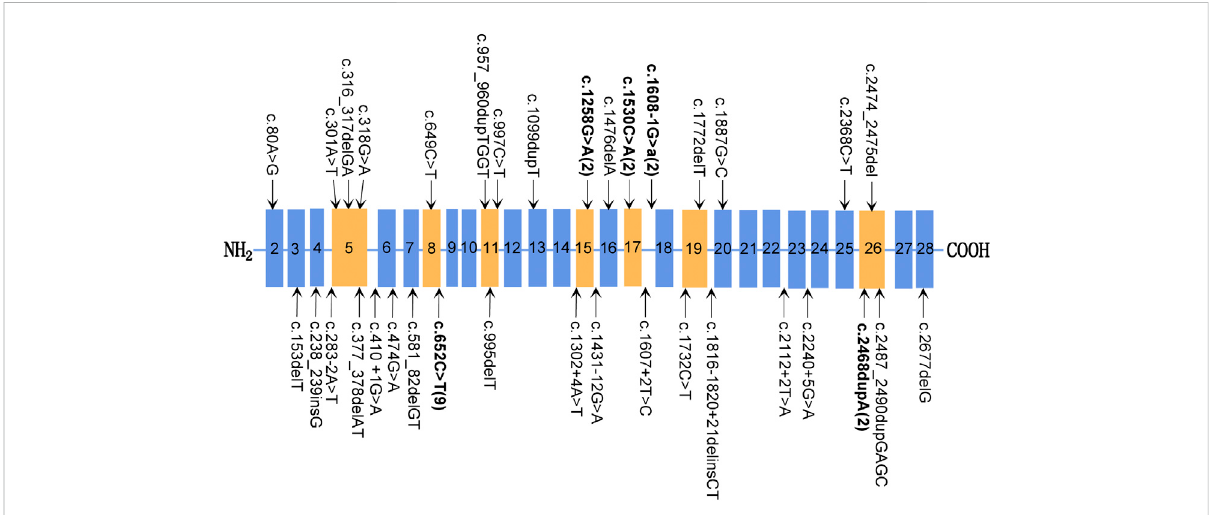
FIGURE 4 Mutations of the SPINK5 gene. Typical exon domains are represented in orange, and other exon domains are depicted in blue. Mutations occurring more than once are shown in bold, and the number of unrelated families carrying this mutation is shown in